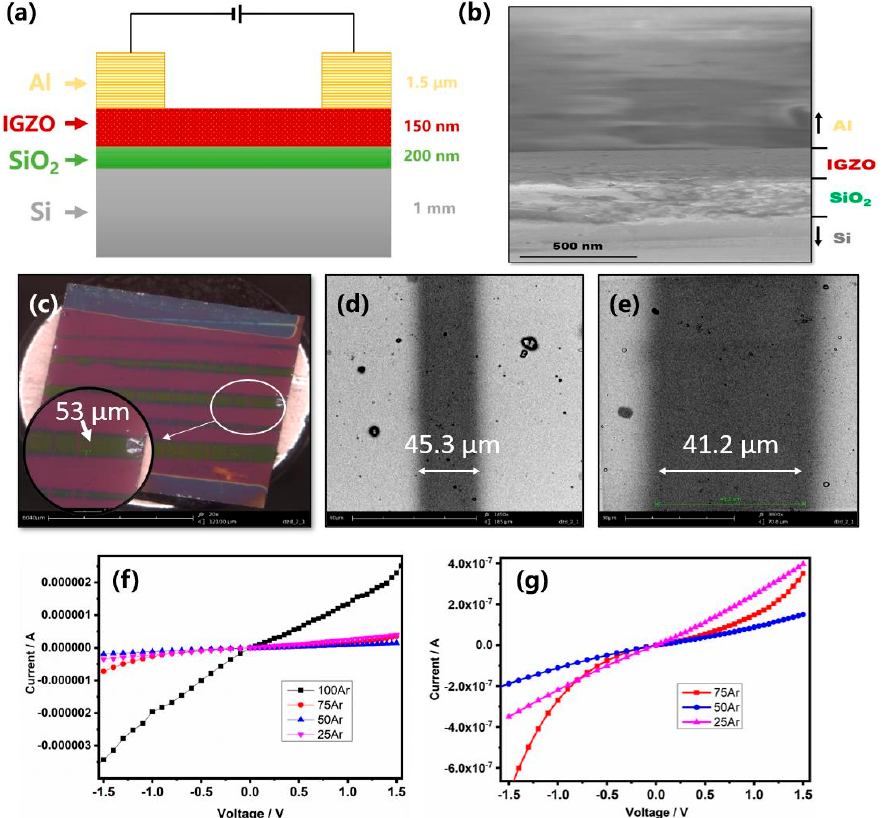
Figure 6. The result of I − V test of IGZO and Al TFT. ( a ) The structure of the TFT; ( b ) The cross-section SEM image of TFT. ( c – e ) The SEM image of the IGZO TFT at 50%-Ar 50% − O 2 ; ( f ) The I − V date; ( g ) The enlarged local data.